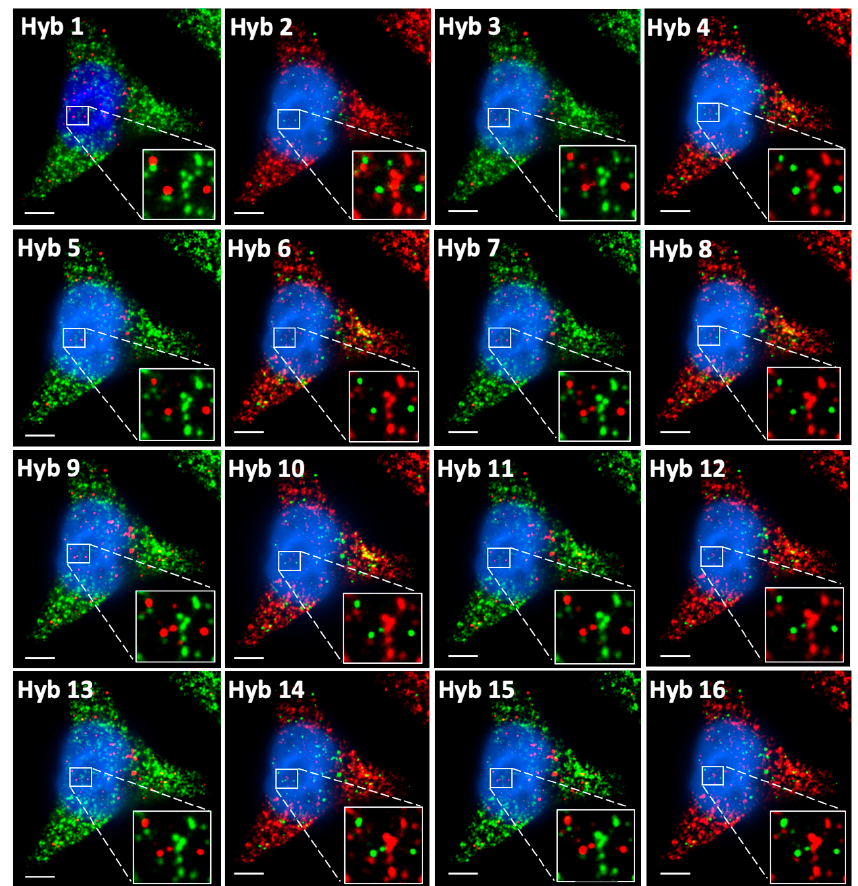
Figure 6. GAPDH and Ki67 transcripts in HeLa cells are detected simultaneously in 16 cycles of C-FISH. Quasar 570 labeled decoding probes were used in the odd hybridization cycles to stain GAPDH and in the even cycle to stain Ki67; Cy5 labeled decoding probes were used in the odd hybridization cycles to stain Ki67 and in the even cycle to stain GAPDH. Scale bars, 5 µm.